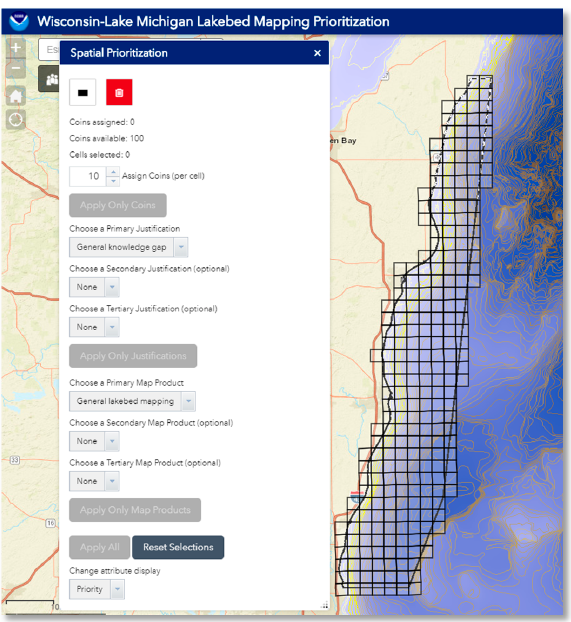
Figure 1. A screen capture of the application interface. Selection options and pull-down menus are seen at left. The selection grid overlaid on the study area wherein respondents place virtual coins is seen at right.